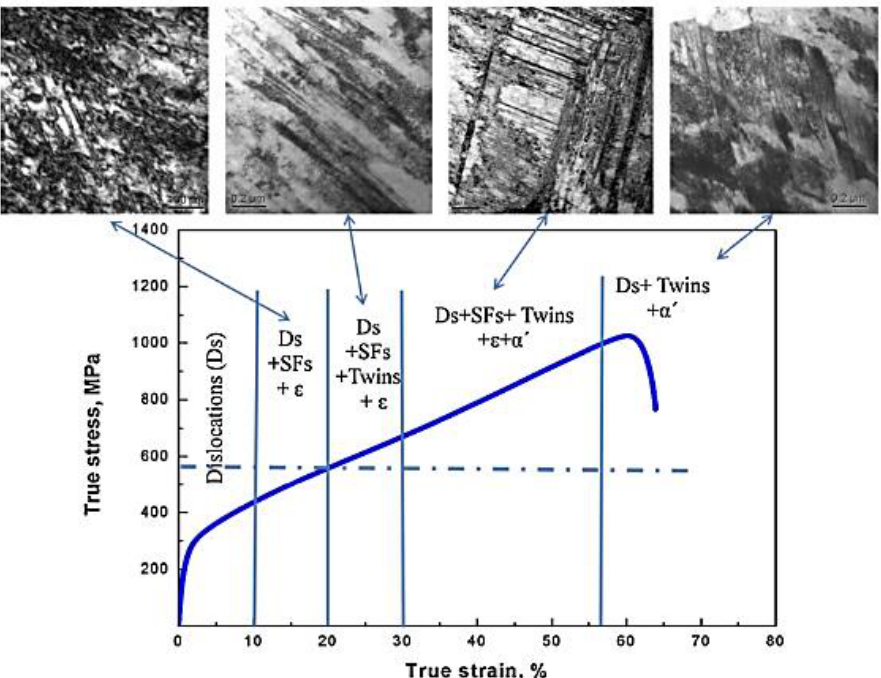
Figure 20. Progression of martensitic structures in 304 SS observed after room temperature deformation. The twin and ε -martensite phases tend to occur in platelets interspersed with one another. The text in the stress-strain plot denotes major forms of defects created during deformation: dislocations (Ds), stacking-faults (SFs), twins, ε-martensite and α’-martensite. Reproduced with permission from [6].